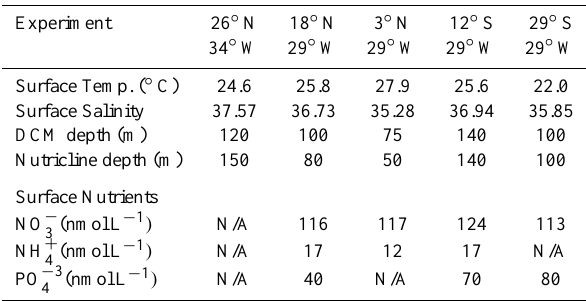
Fig. 1. Map of sampling stations superimposed on a SeaWifs chlorophyll- a monthly composite image (November 2007). Table 1. Summary of initial conditions for each experiment. Sam- pling depth was 10m excepting for experiment at 12 ◦ S 29 ◦ W (15m). Nutricline depth was estimated as the first depth where ni- trate concentration is > 0.5µM. DCM, deep chlorophyll maximum. N/A, not